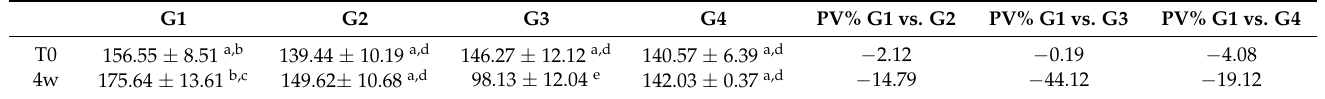
Table 5. Cholesterol content of lyophilized egg yolks quantified by